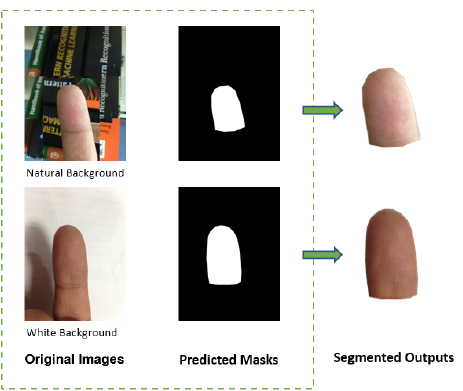
Figure 4. Examples of predicted output masks by using the U-Net framework.